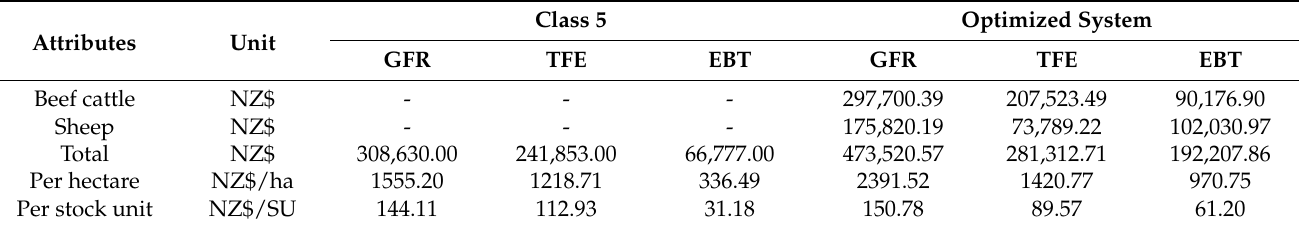
Table 5. Total, per hectare, and per stock unit values of the gross farm revenue (GFR), total farm expenditure (TFE), and farm earnings before tax (EBT) of beef cattle and sheep activity for an average Class 5 farm and the optimized system.